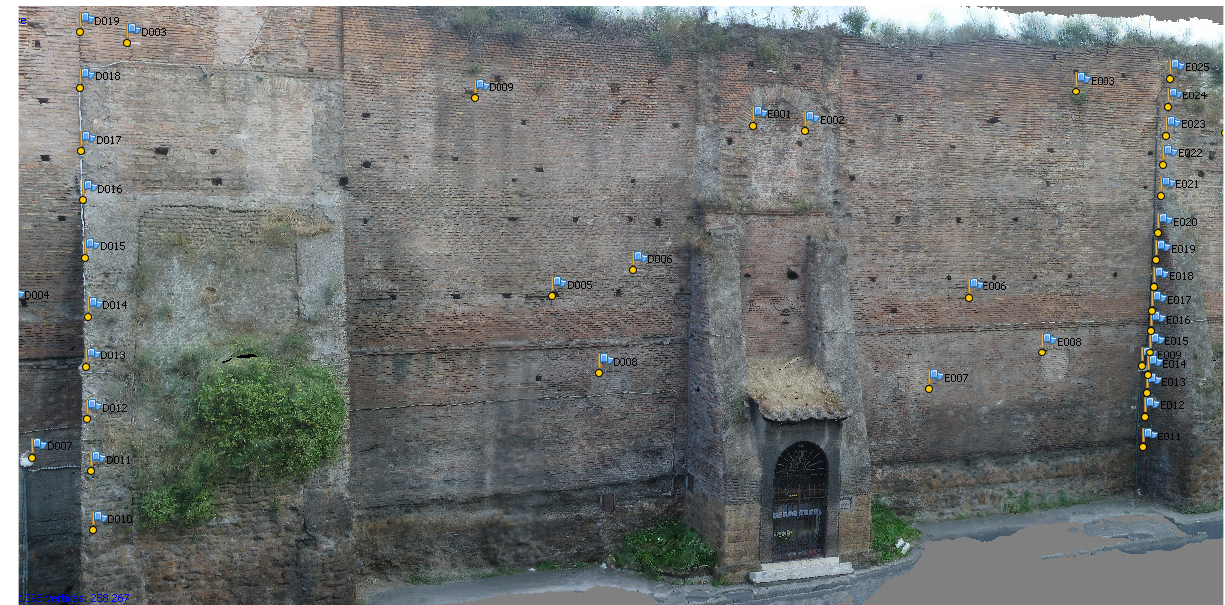
Figure 2. Topographic and Photogrammetric survey: portion of 3D model. The triangulated surface with topographic control points and colour